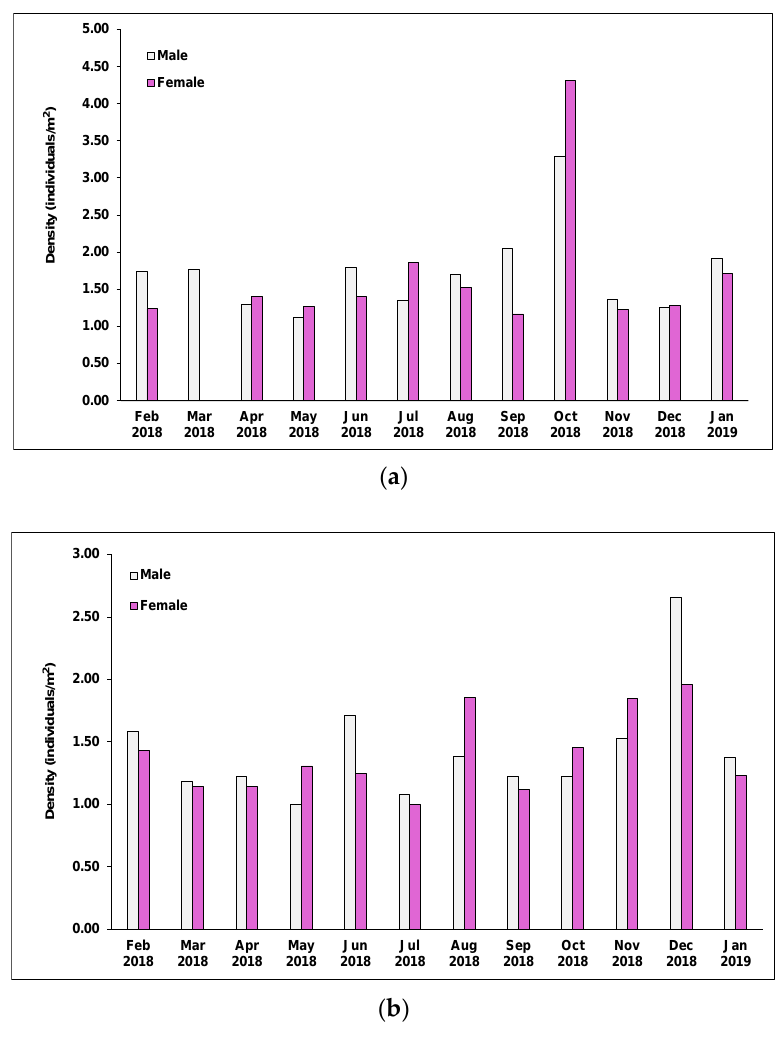
Figure 7. Density of males and females of I. bhumibol in Phu Luang Wildlife Sanctuary ( a ); and Phu Ruea National Park ( b ) between February 2018 and January 2019.